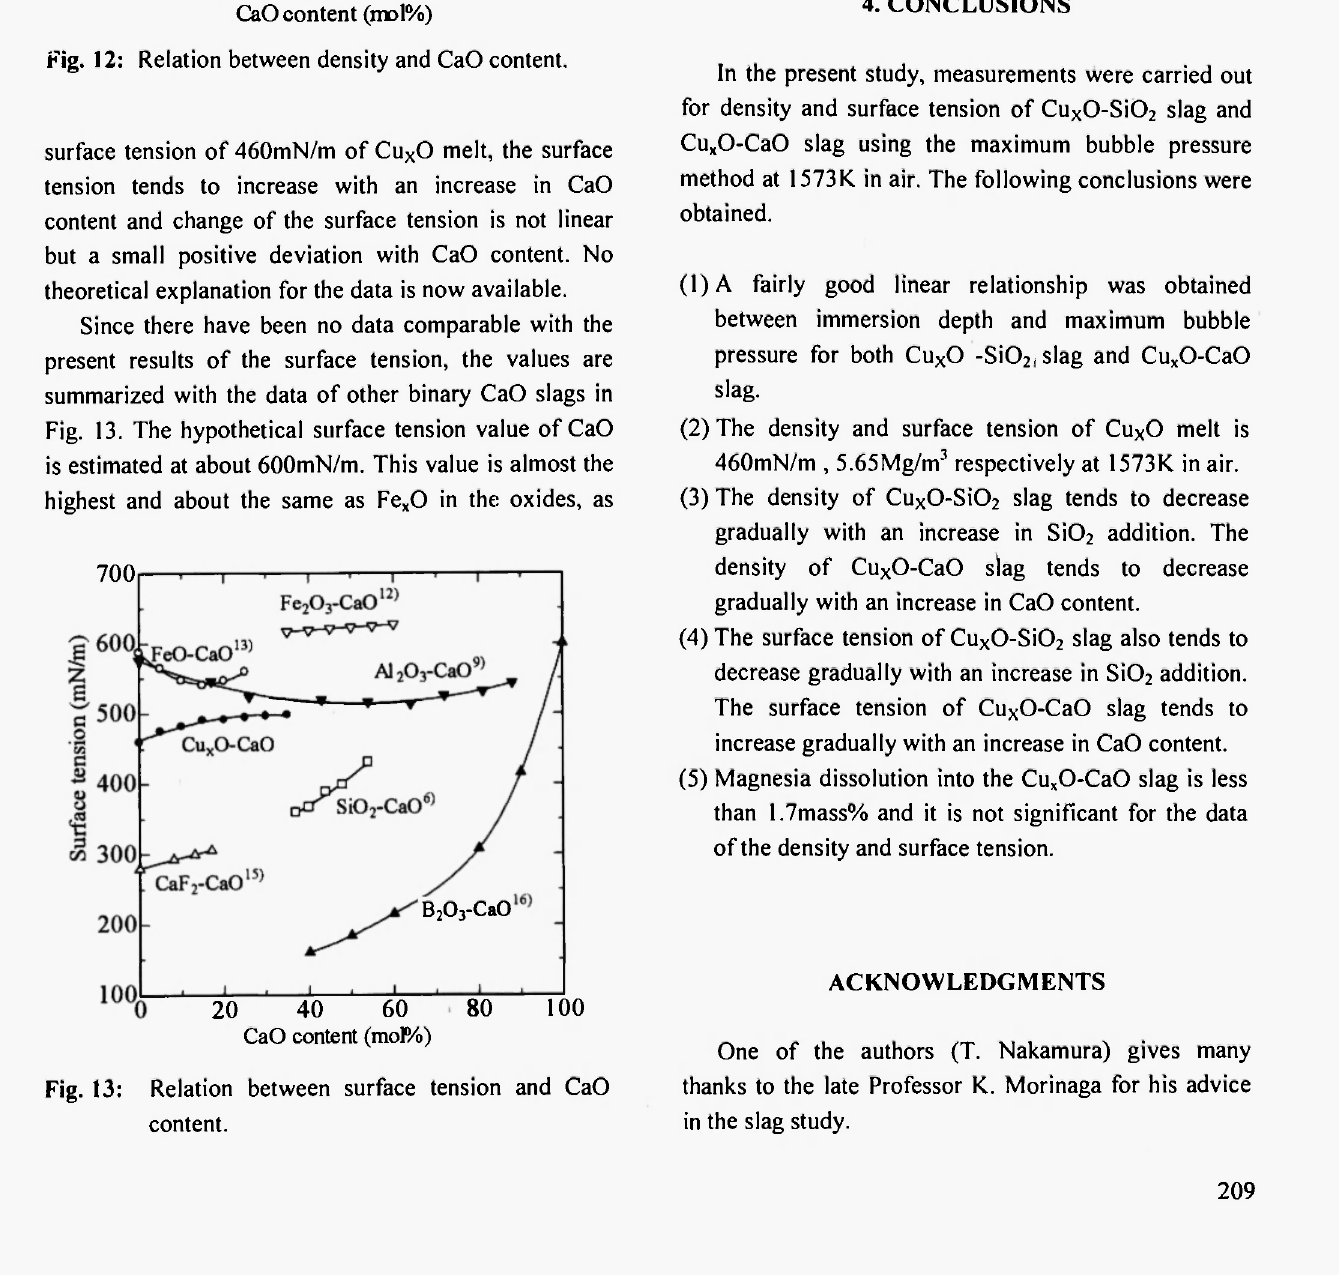
Fig. 12: Relation between density and CaO content.